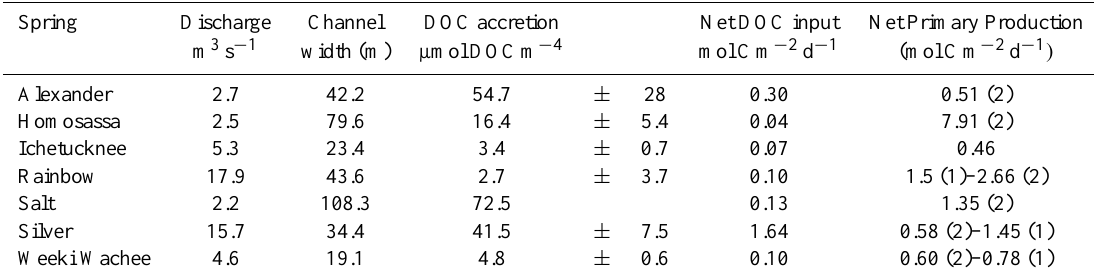
Table 2. Water discharge, mean channel width, net rate of DOC increase (mean ± SE), calculated net input rate of DOC and gross primary production for Florida springs. Salt Springs calculations are based on two points only and have, therefore, no error estimate. Water discharge are the most recent values reported in Scott et al. (2002) and Rosenau et al. (1977). Net primary production from (1) Odum (1957) and (2) Duarte and Canfield (1990a).